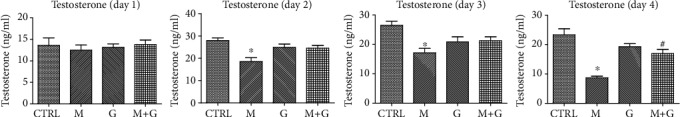
Testosterone concentration of cultured fetal testes. ∗Significantly different from CTRL at P < 0.05; #significantly different from group M at P < 0.05.